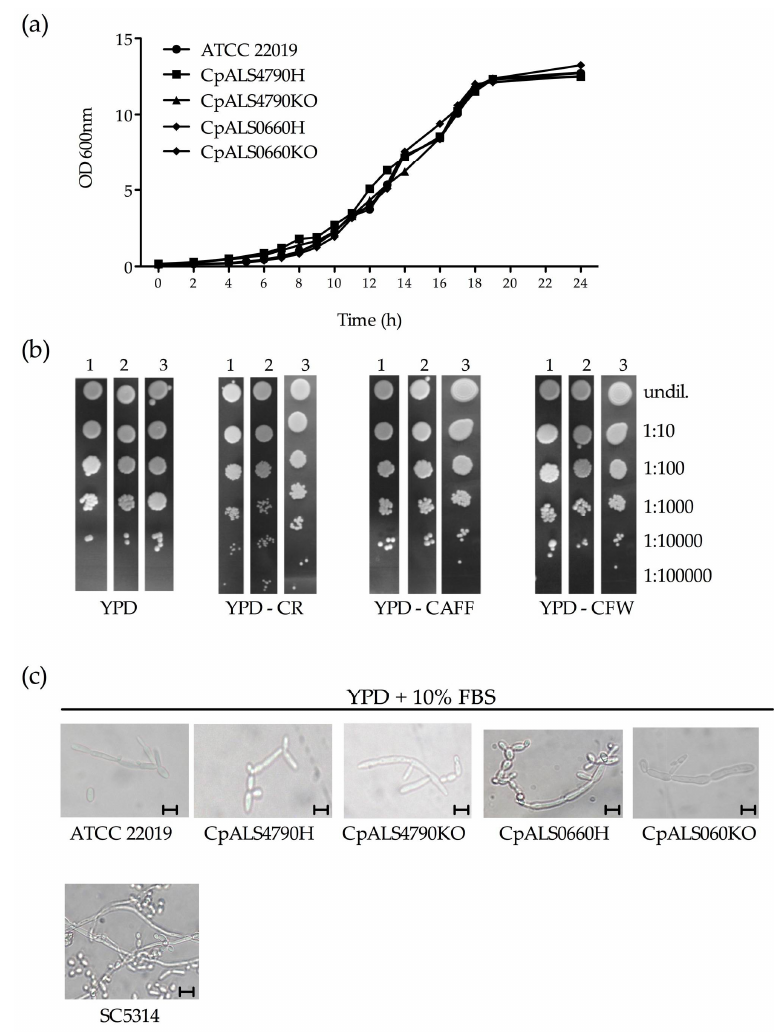
Figure 2. Growth ability and pseudohyphal formation. ( a ) Growth curve of the wild type and mutant collection of CpALS4790 and CpALS0660 in YPD medium at 37 ◦ C. ( b ) Susceptibility to cell-wall perturbing agents of the C. parapsilosis strains was evaluated by spot assay, on YPD agar plates supplemented with the following compounds: congo red (CR, 1 mg / L), ca ff eine (CAFF, 5 mM), calcoflour white (CFW, 20 mg / L). Plates were incubated at 30 ◦ C for 48 h, and visually inspected. 1: